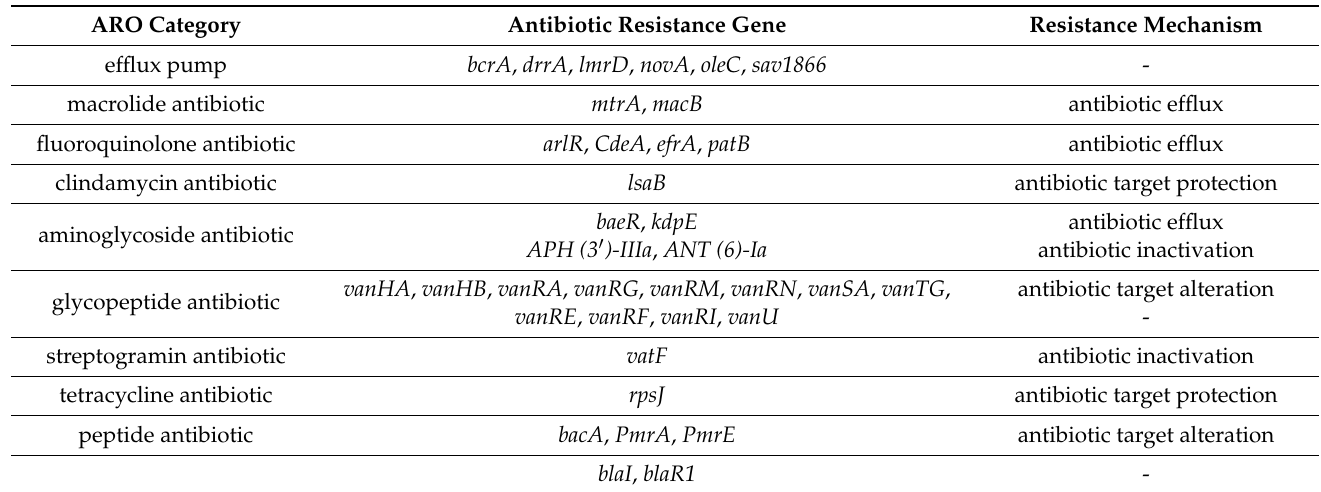
Table 3. Antibiotic resistance genes of Blautia producta DSM 2950.